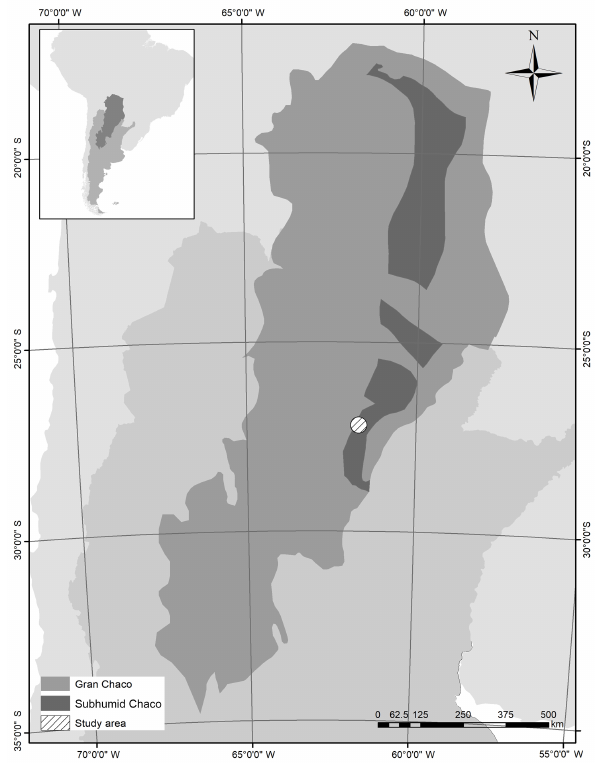
Figure 1. Location of the Gran Chaco, the subhumid Chaco and the study